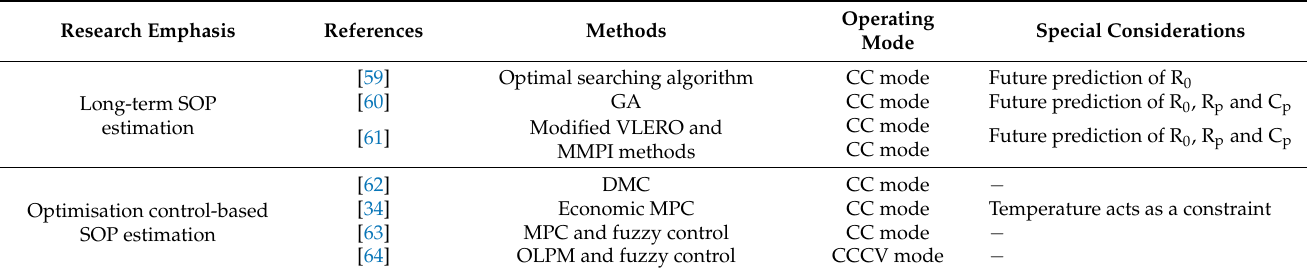
Table 3. Improved SOP estimation methods at different operating